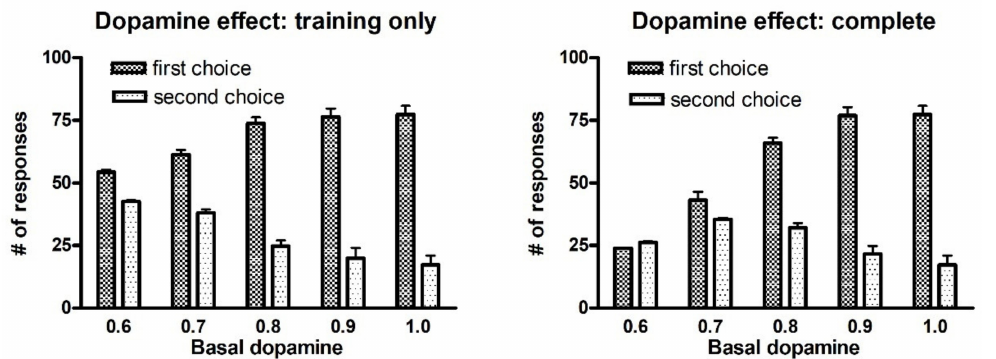
Figure 10. The capacity to perform the task correctly (i.e., to select the more correct response, that is the first choice), in a two-action task as a function of the basic dopaminergic input (post-post rule). Each test consists of 100 trials, in which the stimulus associated with each action is given 50 times. The bars represent mean values and standard deviation on 10 independent learning procedures. The left panel displays the case in which a reduced dopaminergic input is used during training, but a normal dopaminergic input is restored during the test (medication). In the right panel, a reduced dopaminergic input was used both during training and